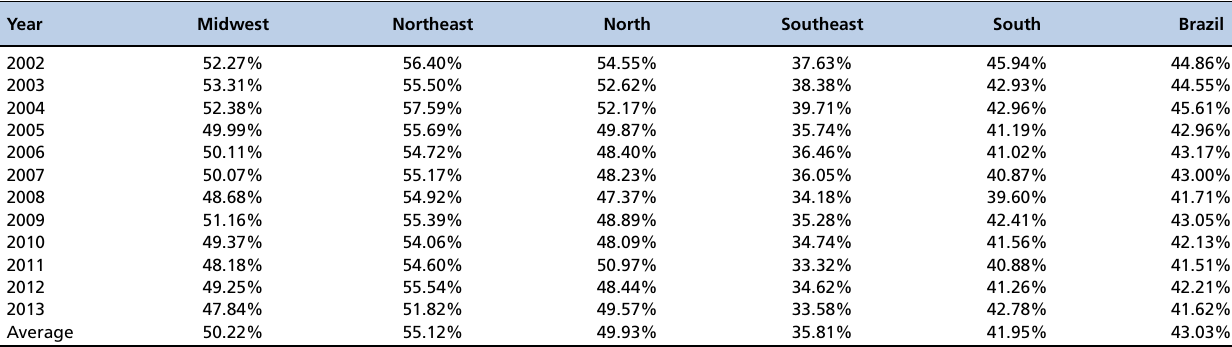
Table 2 - Share of total transfers for health care spending by municipalities, states and the Federal District (excluding spending financed with funds from loans and other sources) by region of the country during the period from 2002 to